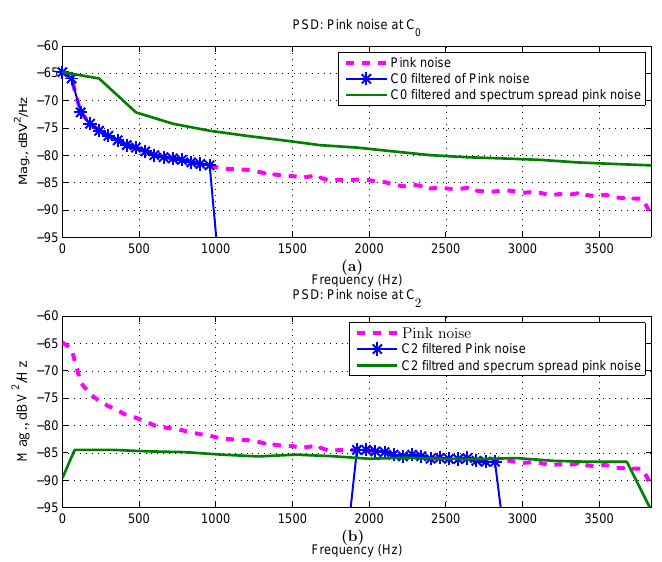
Figure 4. The stretching effect of the filter bank (FB) followed by spectrum spread inherent to FB-ESPRIT on the pink noise sub-band spectrum; ( a ) the subband C 0 , and ( b ) the subband C 2 after spread spectrum